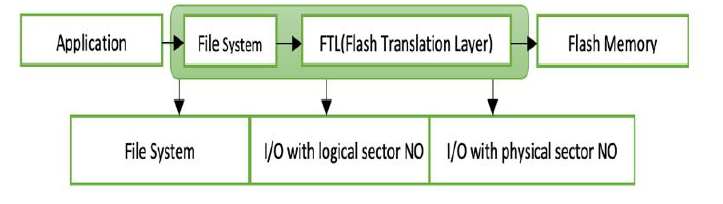
Figure 1. An overview of the flash memory system